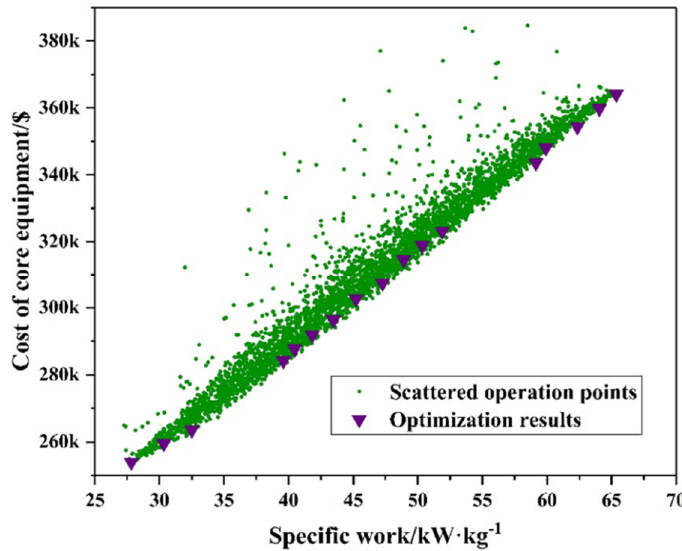
Figure 11. Optimization result of the intercooling cycle.